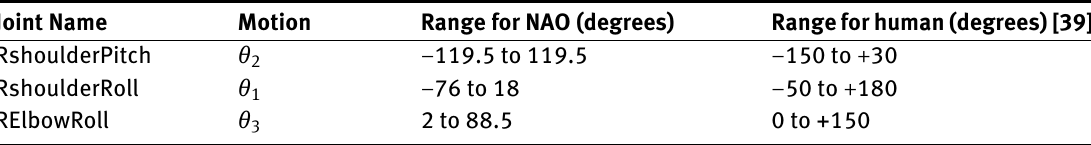
Table 2: Upper Arm Range of Motion of NAO Robot and